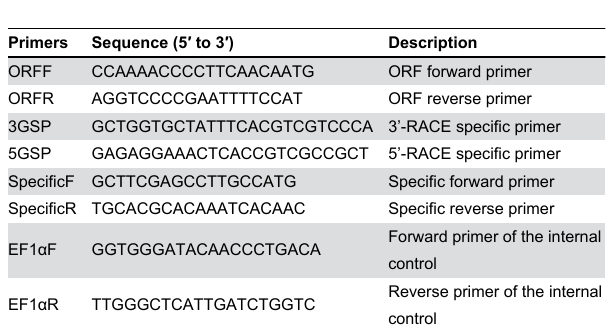
Table 1. Oligonucleotide sequence of primers and their